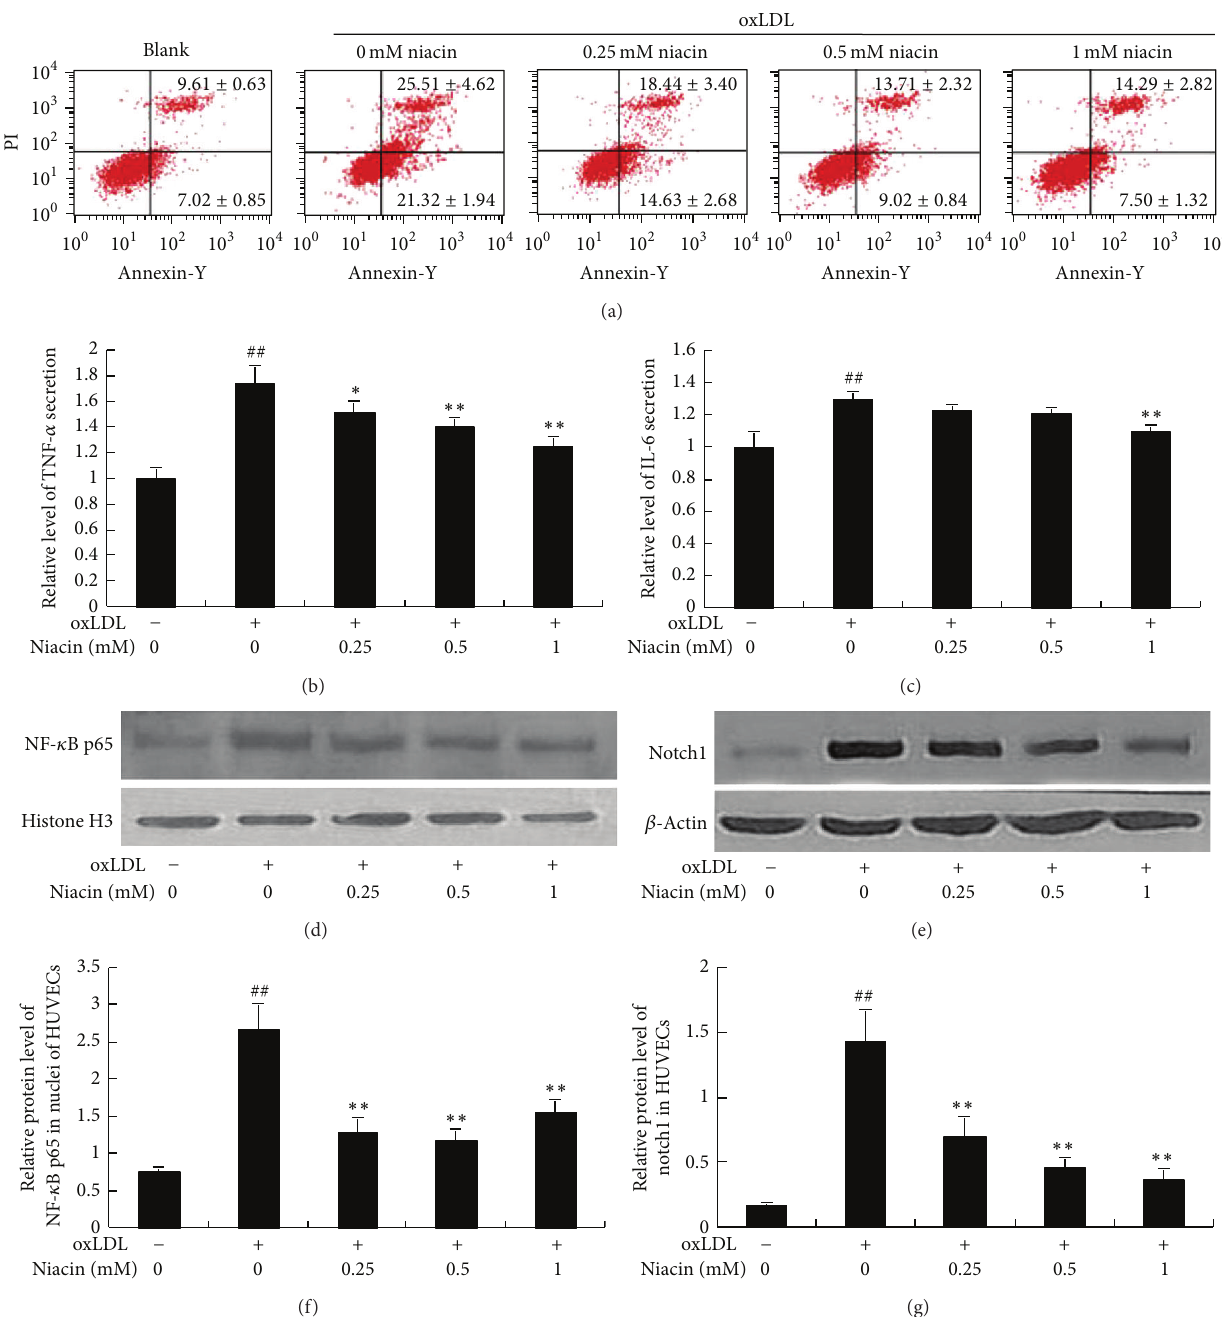
Figure 4: Niacin inhibited oxLDL-stimulated apoptosis and inflammation in HUVECs. (a) shows the ratio of apoptotic HUVECs stained with annexin V-FITC and PI. Representative data of flow cytometry analysis are presented. (b) and (c) show the relative levels of TNF- 𝛼 and IL-6 in the medium of HUVECs. The concentrations of IL-6 and TNF- 𝛼 were determined by ELISA kit. (d) and (e) show the representative images of NF- 𝜅 B p65 and notch1 protein expression in HUVECs by western blot. (f) and (g) show the IOD ratios of NF- 𝜅 B p65 and notch1 expression, respectively. Data are presented as mean ± SD. ## 𝑃 < 0.01 versus blank group; ∗ 𝑃 < 0.05 ; ∗∗ 𝑃 < 0.01 versus oxLDL-treated group without